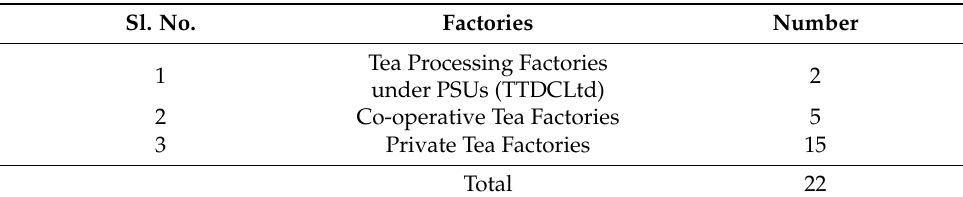
Table 2. Position of functioning Tea Factories. Sl. No. Factories Number 1 under PSUs (TTDCLtd) 2